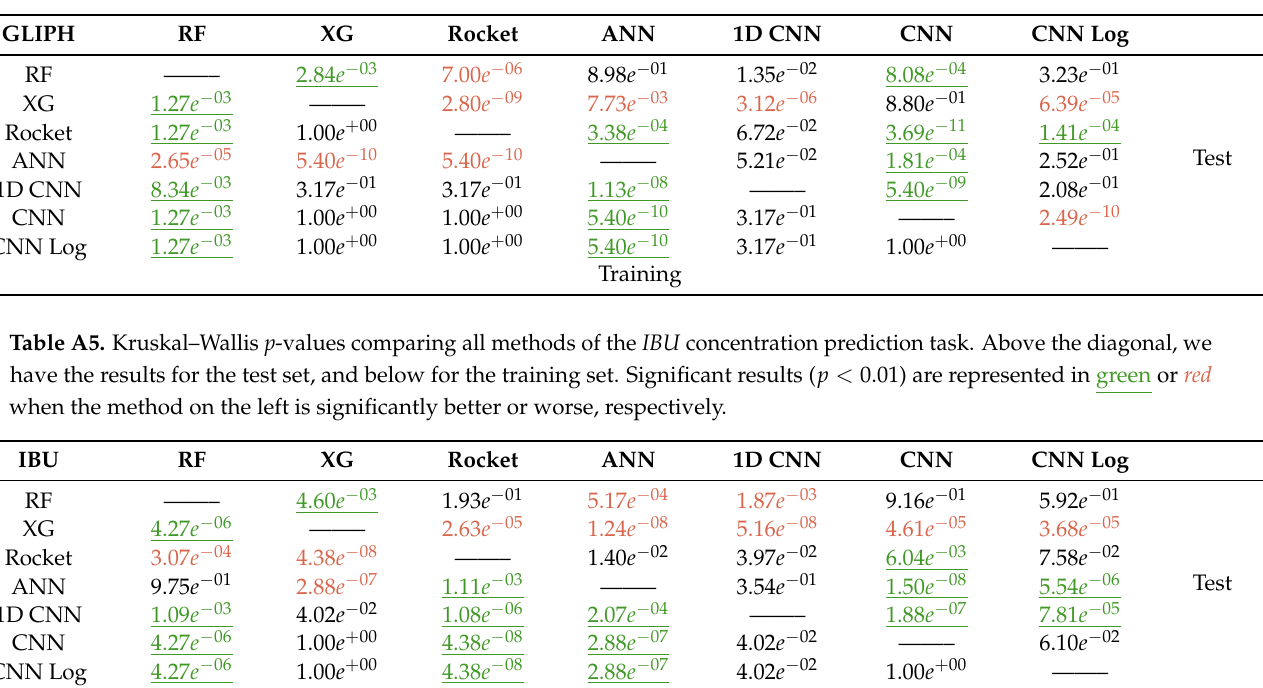
Table A4. Kruskal–Wallis p -values comparing all methods of the GLIPH concentration prediction task. Above the diagonal, we have the results for the test set, and below for the training set. Significant results ( p < 0.01) are represented in green or red when the method on the left is significantly better or worse, respectively.